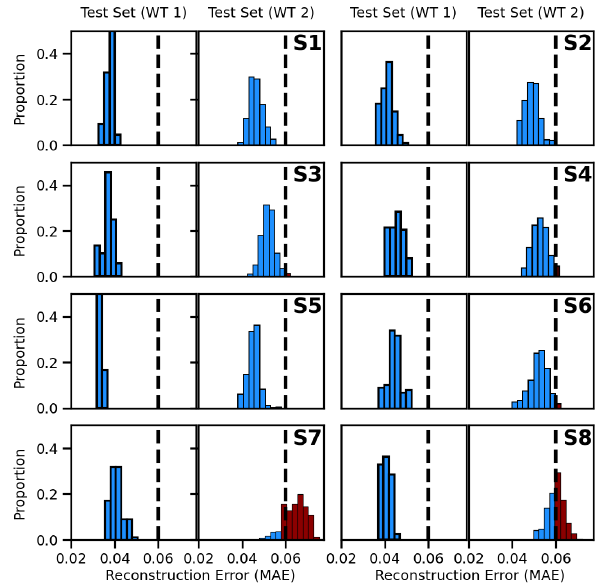
Figure 6. Fault detection based on spectrogram reconstruction. Reconstruction errors for accelerometers S1 – S8 after reconstruction with a convolutional autoencoder. The spectrograms from the test set of WT1 are specified as healthy based on their comparatively low reconstruction errors, which is consistent with the logs of WT1. In contrast, the spectrograms of accelerometers S7 and S8 of WT2 indicate damage conditions in the generator. This finding was confirmed by the logs of WT2.